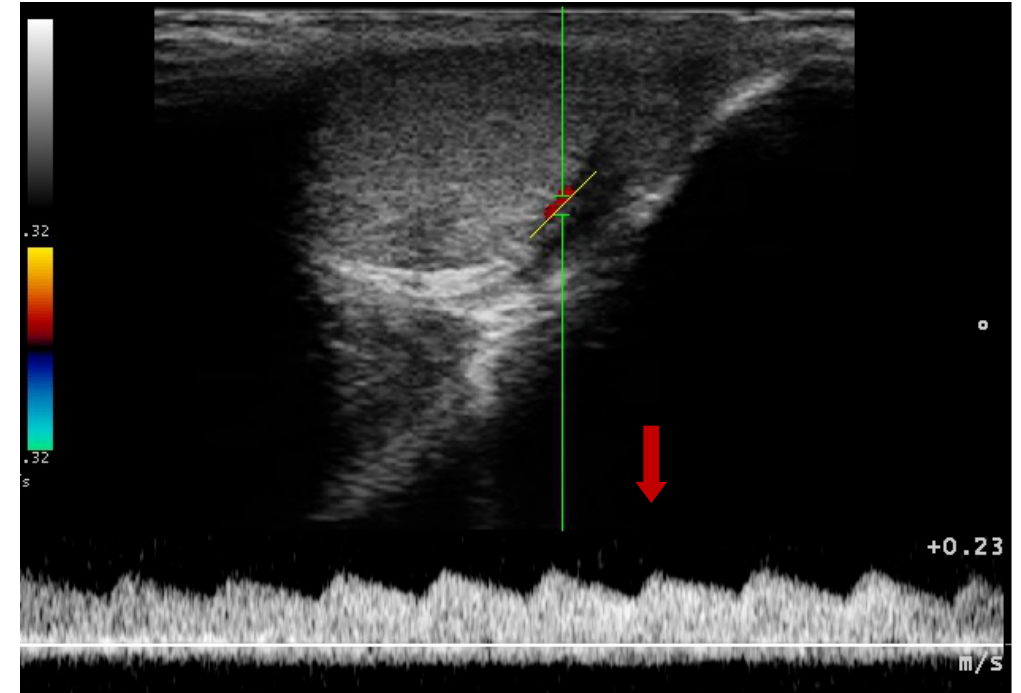
Figure 7. Blood flow pattern using a duplex technique in the testicular artery. Flow towards probe, red arrow— systolic peak velocity, wide parabolic flow profile, no spectral window visible, gradual decrease of velocity in diastole.